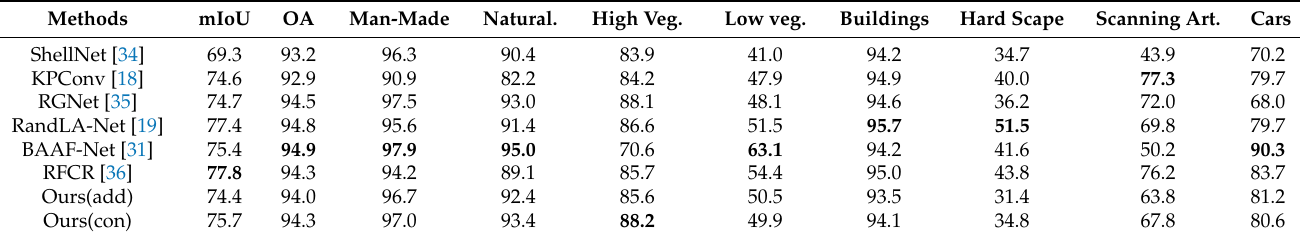
Table 3. Quantitative results on the Semantic3D dataset (add: the two attention weight matrices added; con: the two attention weight matrices fused at the feature level).